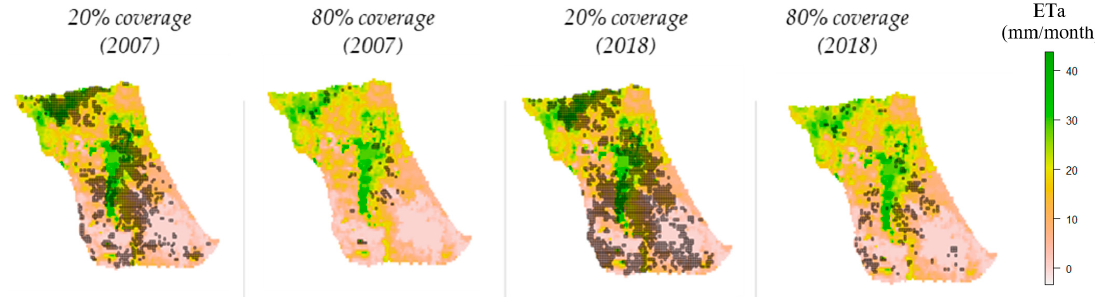
Figure 4. Actual Evapotranspiration in Sub-13. The grids (black) represent ETa cells having different percentages (at least 20% and 80%) of almond crops. For our purpose, we use only 80% coverage (at least). Here, we show both low (20%) and high (80%) fractional coverage of almond to represent the spatial distribution of almond throughout the subregion. All the selected grids are plotted over ETa on January, 2003.